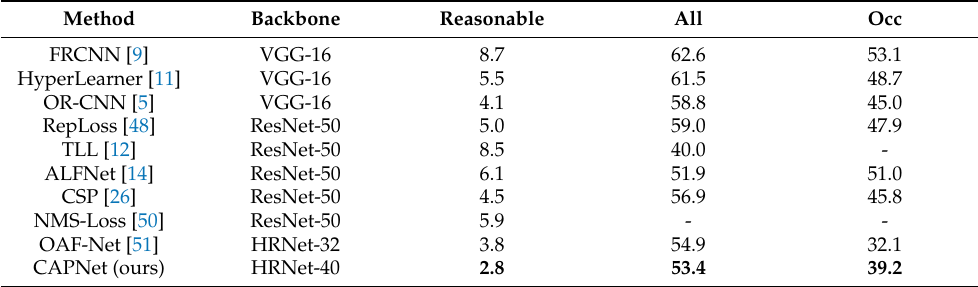
Table 3. The performance comparison between CAPNet and other state-of-the-art methods on three subsets of Caltech. The best results are highlighted in